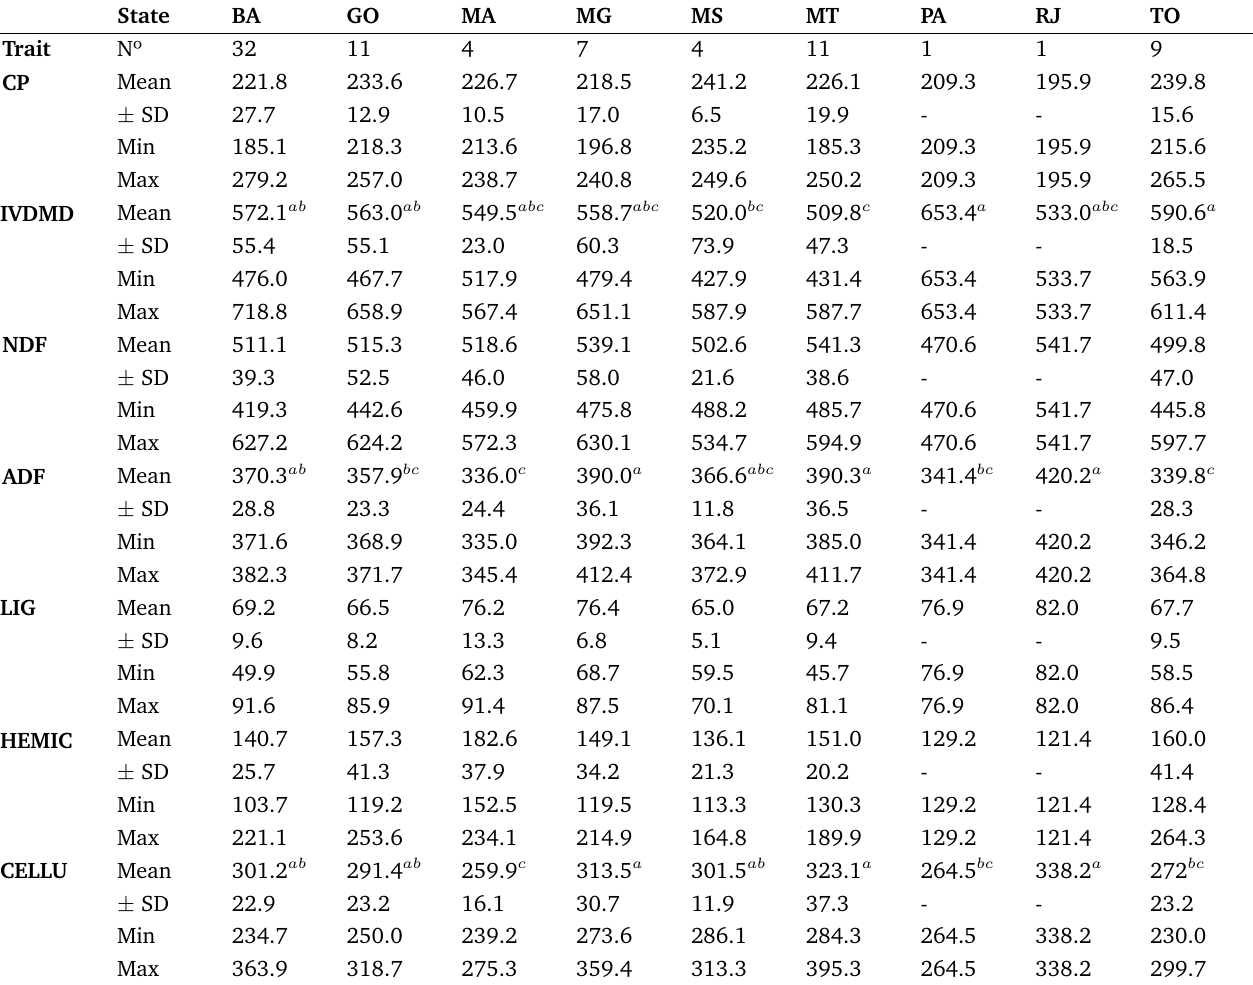
Table 3. Seven quality traits, estimated from 80 Stylosanthes scabra Vogel germplasm accessions by Brazil source states. Given are the number of accessions per state and values in g/kg for means ± standard deviation (Mean ± SD), minimum and maximum values (Min, Max). Brazilian states: BA, Bahia; GO, Goi´as; MA, Maranh˜ao; MG, Minas Gerais; MT, Mato Grosso; MTS, Mato Grosso do Sul; PA, Par´a; RJ, Rio de Janeiro; TO, Tocantins.CP, Crude Protein; IVDMD, In Vitro Dry Matter Digestibility; NDF,